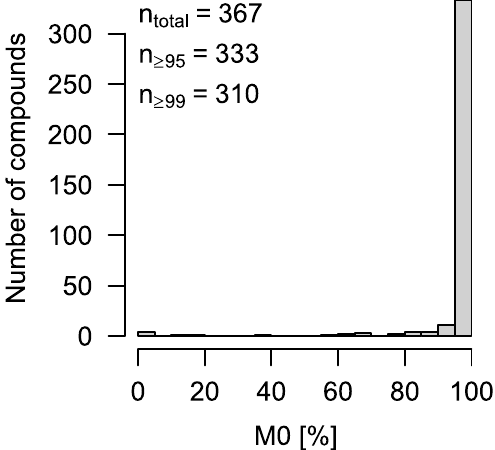
Figure 2. Histogram of estimated M0 for 367 library spectra. Ideally, all compounds are M0 = 100%. However, due to spectral impurities, this is only true for 288 compounds, or 78%. Still, more than 90% of all compounds ( n = 333) show an automatic solution with M0 ≥ 95%.